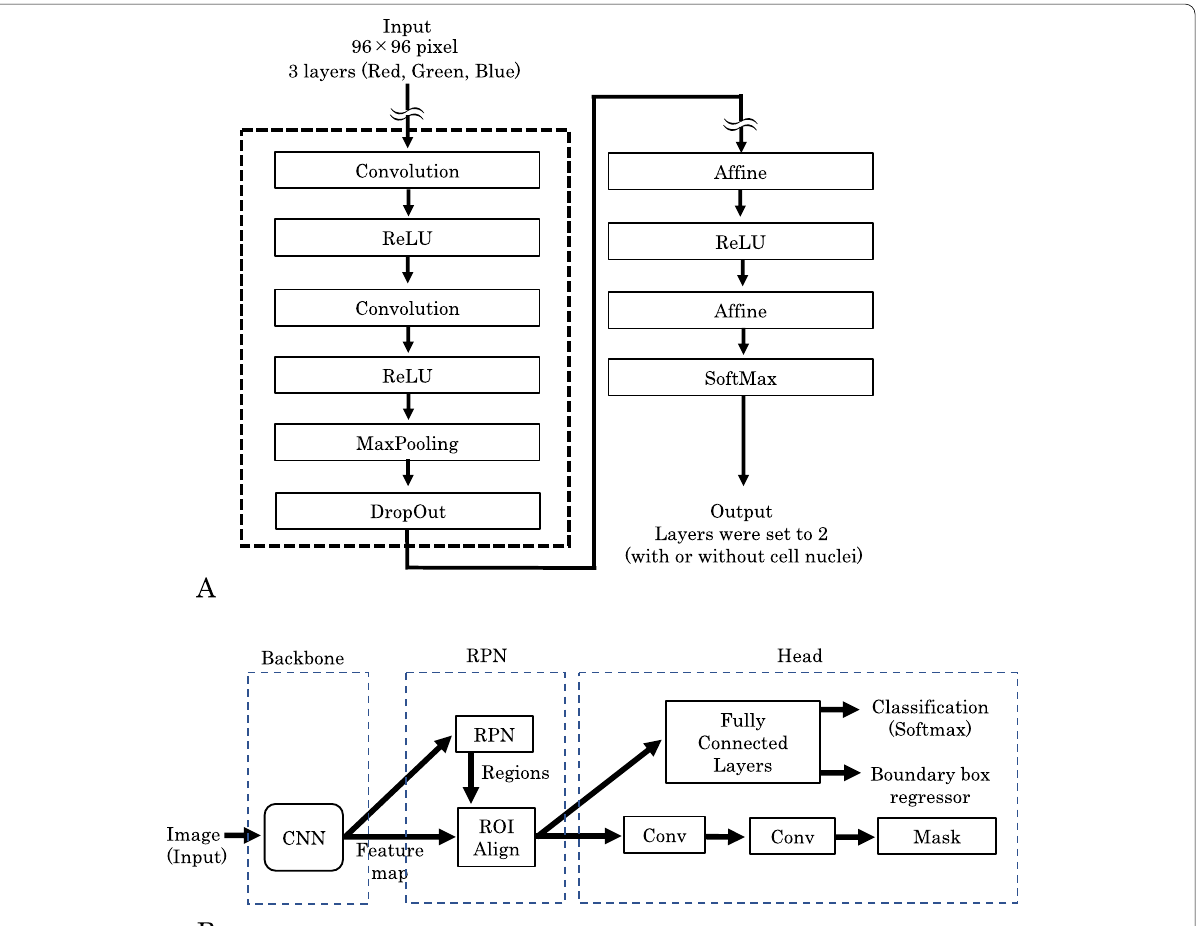
Fig. 2 Constructed image classifier. A Image classifier using the sliding window method. Categorical cross-entropy was used as the loss function, and ADAM software was used to update the parameters. The input layer was set to 96 96 with three channels (red, green, and blue), while × the output layer was set to two, one containing the cell nuclei and the other without the cell nuclei, respectively. B Image classifier with mask region-based convolutional neural network method (Mask-RCNN). Mask-RCNN consists of three regions: backbone, region proposal network (RPN), and head. The backbone extracts features of the input image. The RPN determines whether each fixed region and the overlap of the regions are correct. The head layer pools the candidate RPN regions to the same image size and then calculates the probability for each class of cytology. CNN, convolutional neural network; ROI, region of interest; Conv, convolutional